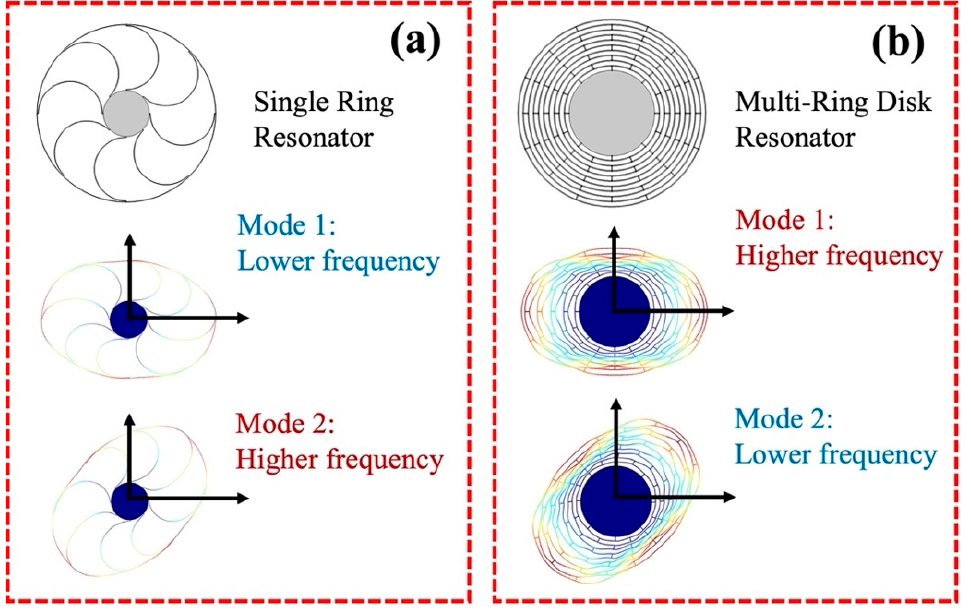
Figure 2. Frequency order between Mode 1 and Mode 2, in ( a ) single-ring resonator and ( b ) multi-ring disk resonator.